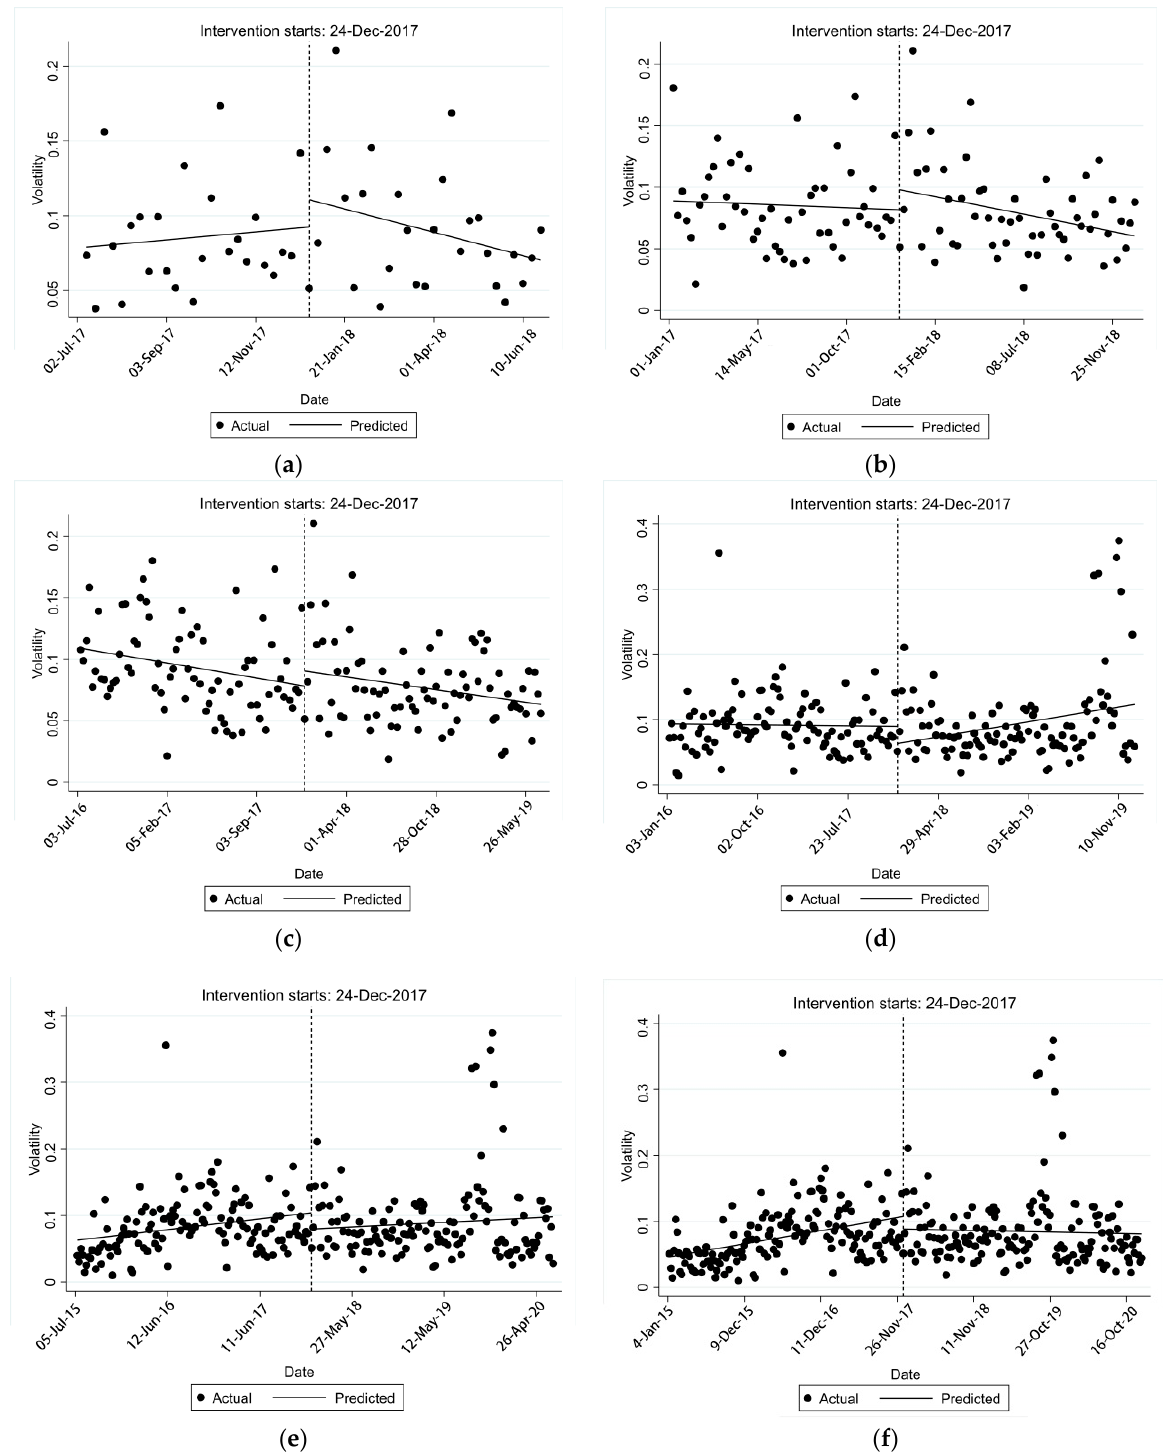
Figure 3. ITSA analysis chart for each time period: ( a ) 1 July 2017 to 30 June 2018; ( b ) 1 January 2017 to 31 December 2018;